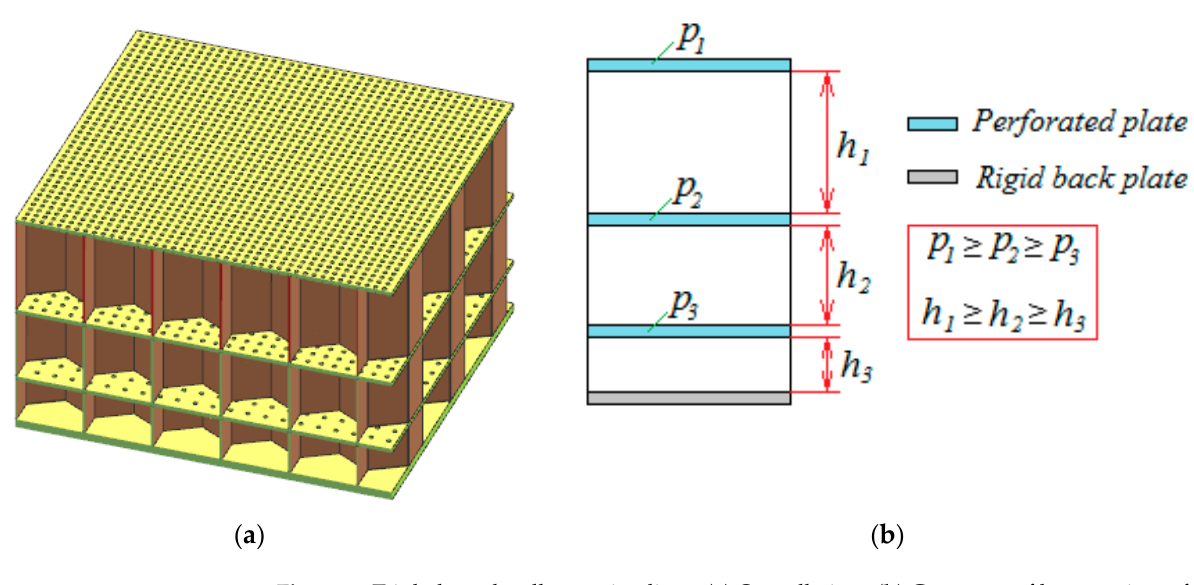
Figure 1. Triple-layer locally reacting liner: ( a ) Overall view; ( b ) Geometry of layers; p is perforation degree; h is height of resonant cavity.